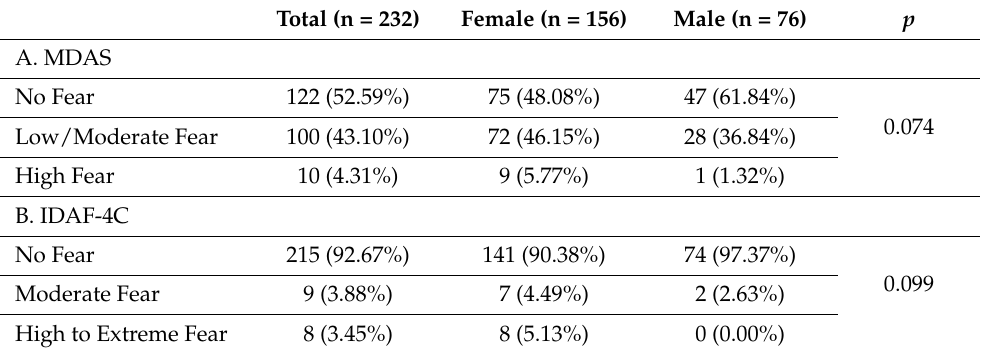
Table 3. Prevalence of fear.